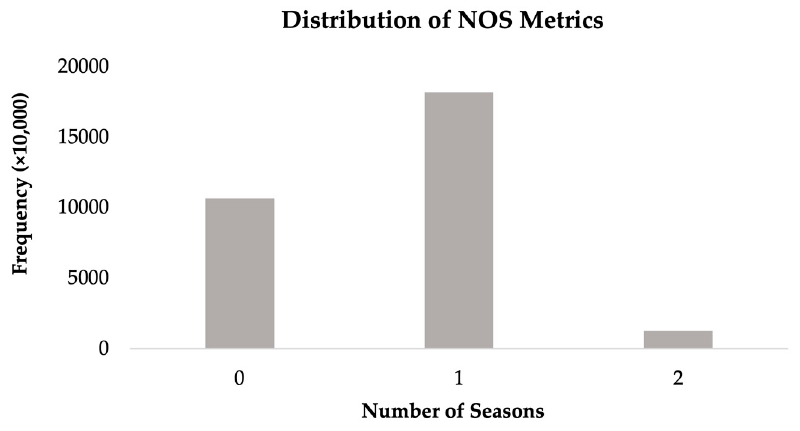
Figure 12. Distribution of the number of seasons (NOS) metric across all vegetation land cover classes within the study area. A NOS value of 0 indicates areas filtered out with the phenology extraction algorithm, including barren land, urban, and cropland.